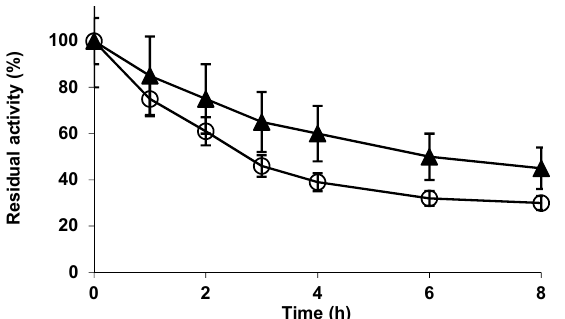
Figure 5. Effect of glutaraldehyde modification on the stability of immobilized Alcalase. The enzyme was modified at pH 7 with 0.1% ( v / v ) for 1 h, washed and incubated 3 h at pH 8 before reduction. Inactivation was performed at pH 7 and 54 ◦ C. Other specifications are described in methods. Glx-AL: open circles; Glx-AL-GLU: solid